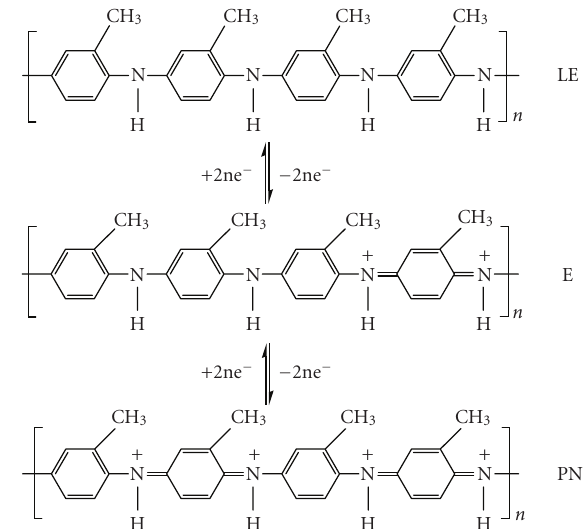
Figure 3: Reaction schemes for the electrochemical process of POT film in acidic solutions.